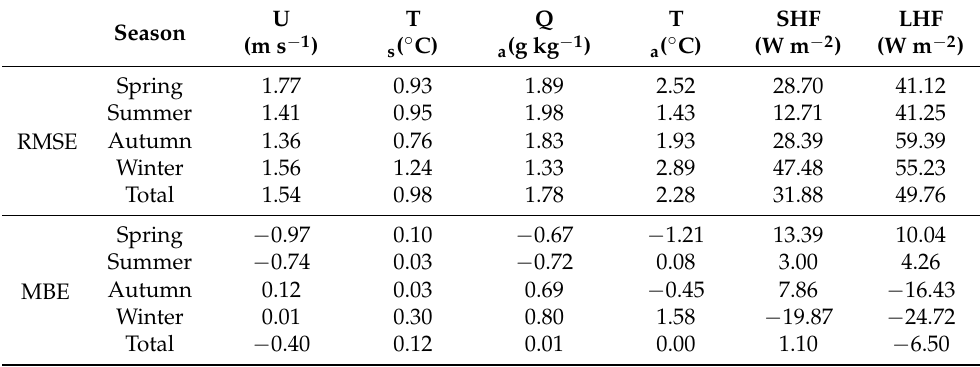
Figure 3. Comparison of daily mean ( a ) specific humidity (Q a ) and ( b ) air temperature (T a ) derived from satellite and buoy observations during the period 2014–2019. The dashed line is the 1:1 line. The color scale represents the density (%) of the data points.